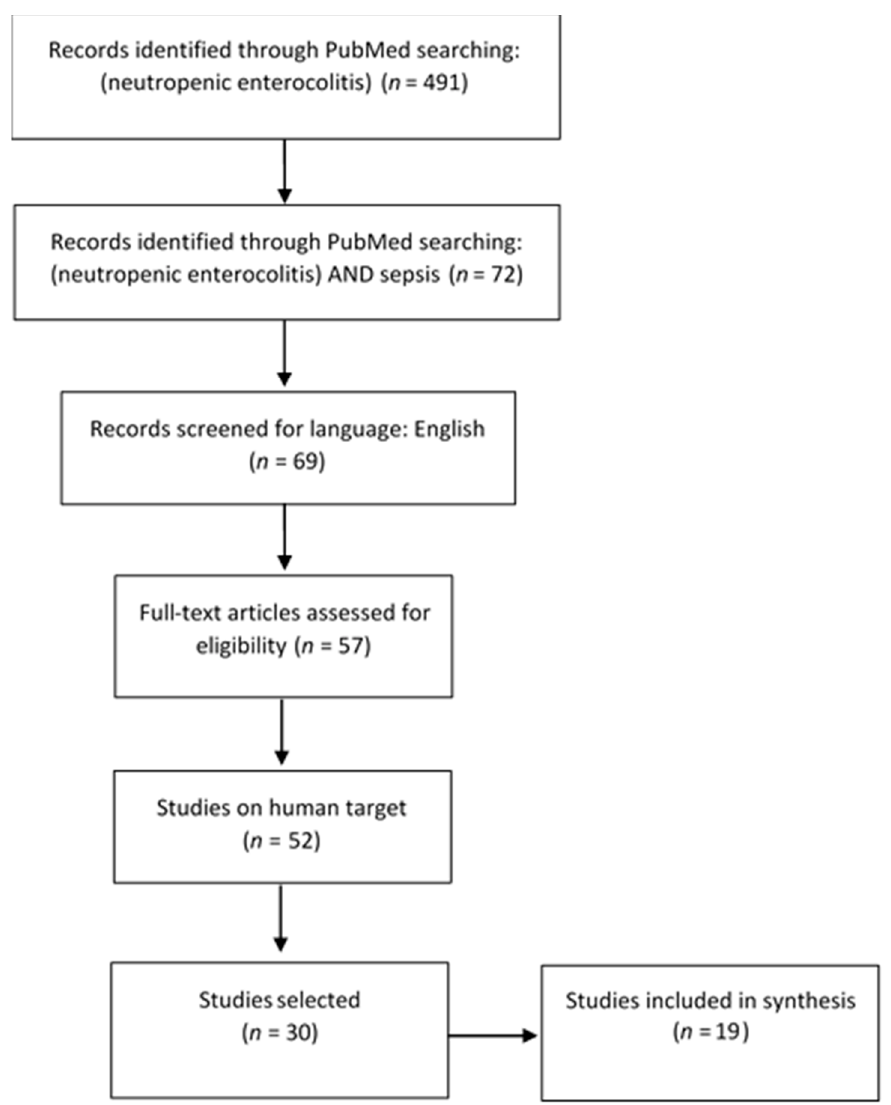
Figure 2. Review flow diagram, according to PRISMA guidelines.